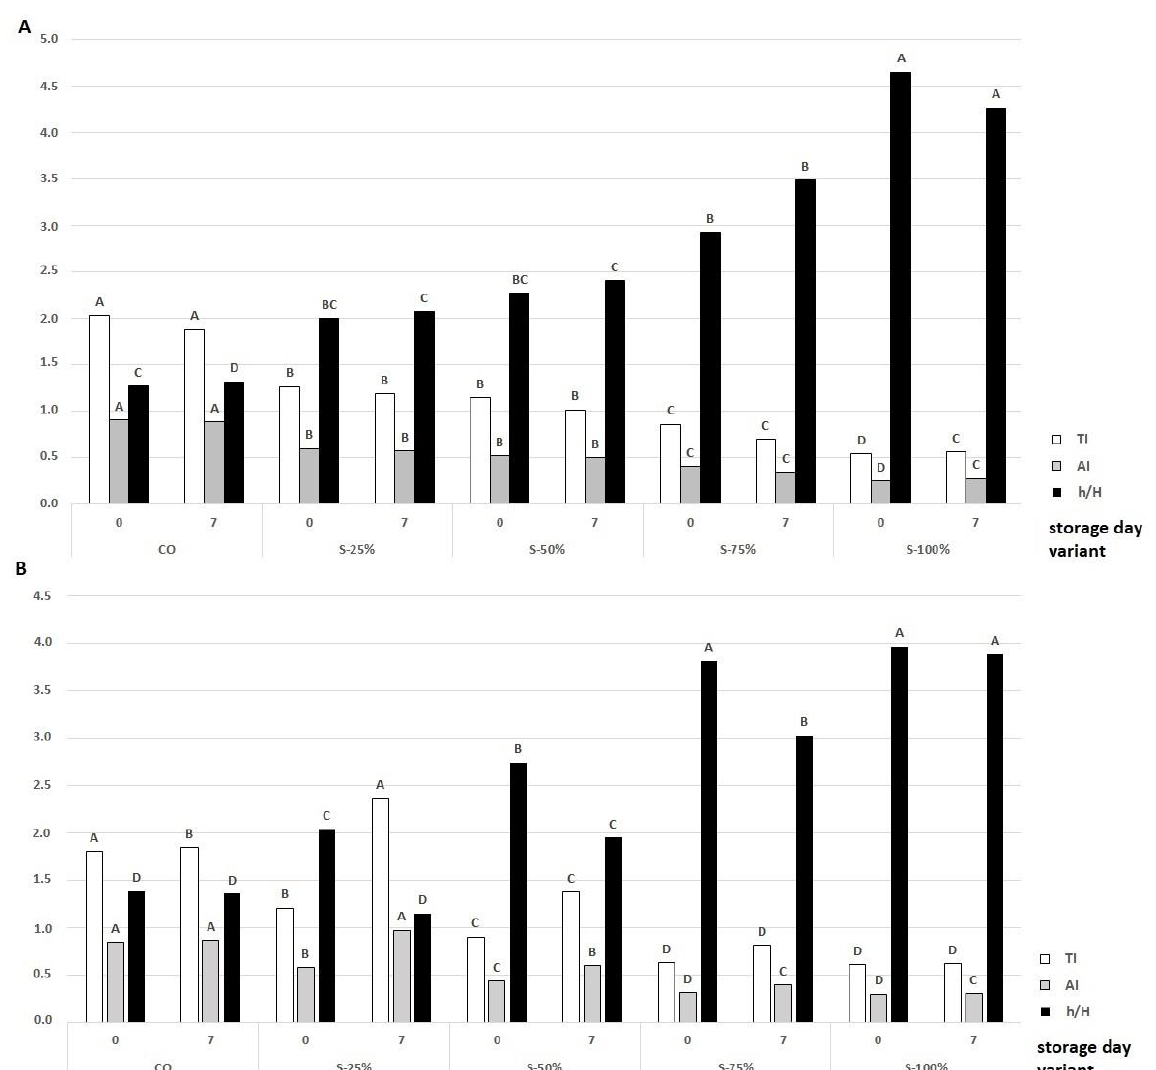
Figure 7. Effects of a fat substitute (freeze-dried hydrogel emulsion with encapsulated açai oil) on the nutritional indexes AI, TI, and h/H of raw ( A ) and grilled ( B ) burgers at 0 and 7 days of storage in cold conditions; CO-control with tallow (0% fat substitute), S-25%, S-50%, S-75%, S-100% means respectively replacing beef fat with 25, 50, 75, and 100% substitute. A–D —means with different letters showing a significant effect of the treatment group in the same day of storage, p < 0.05.